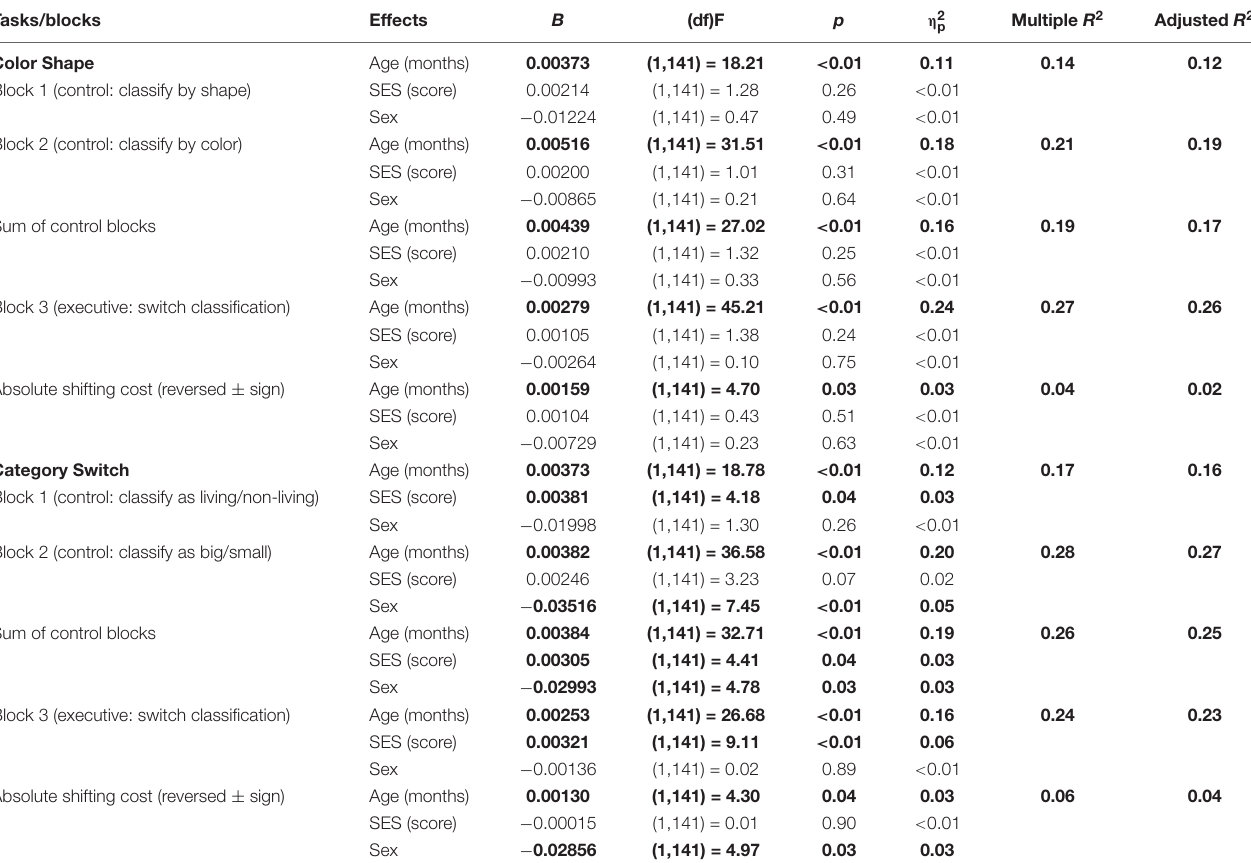
TABLE 4 | Results from the General Linear Models for executive shifting tasks/blocks and absolute executive costs, including age, sex and socioeconomic status (SES) effects. Tasks/blocks